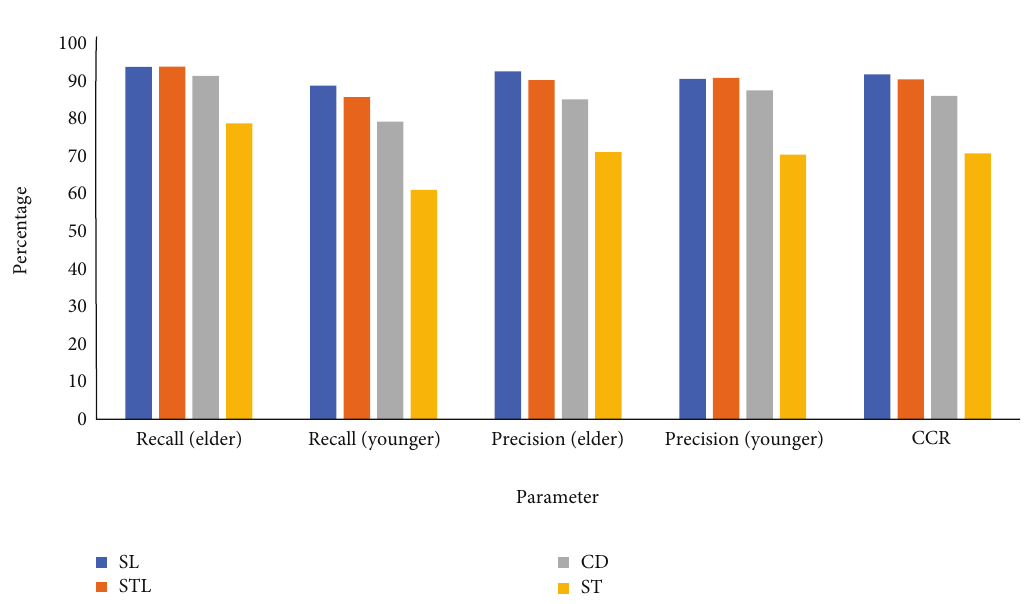
Figure 8: Age recognition with GA and SVM.